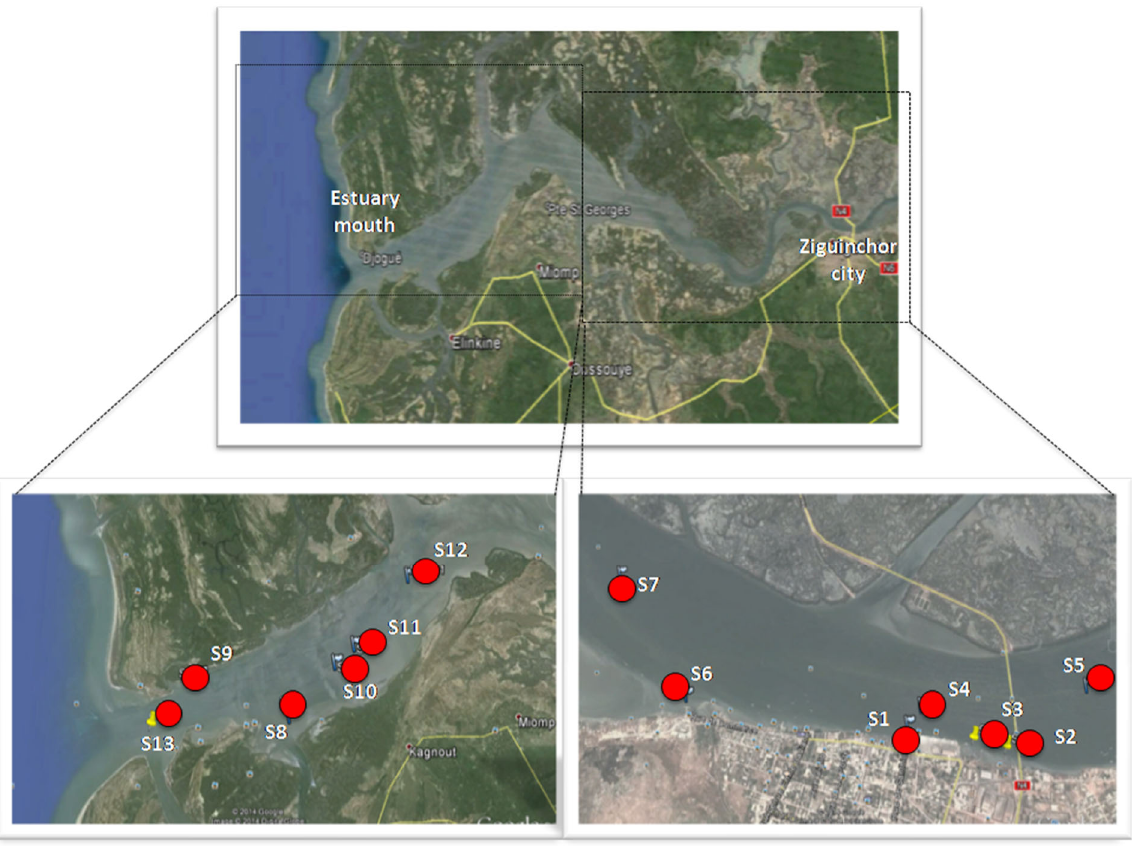
Figure 1. Map showing the benthic fauna sampling stations along the road channel of the Casamance estuary.